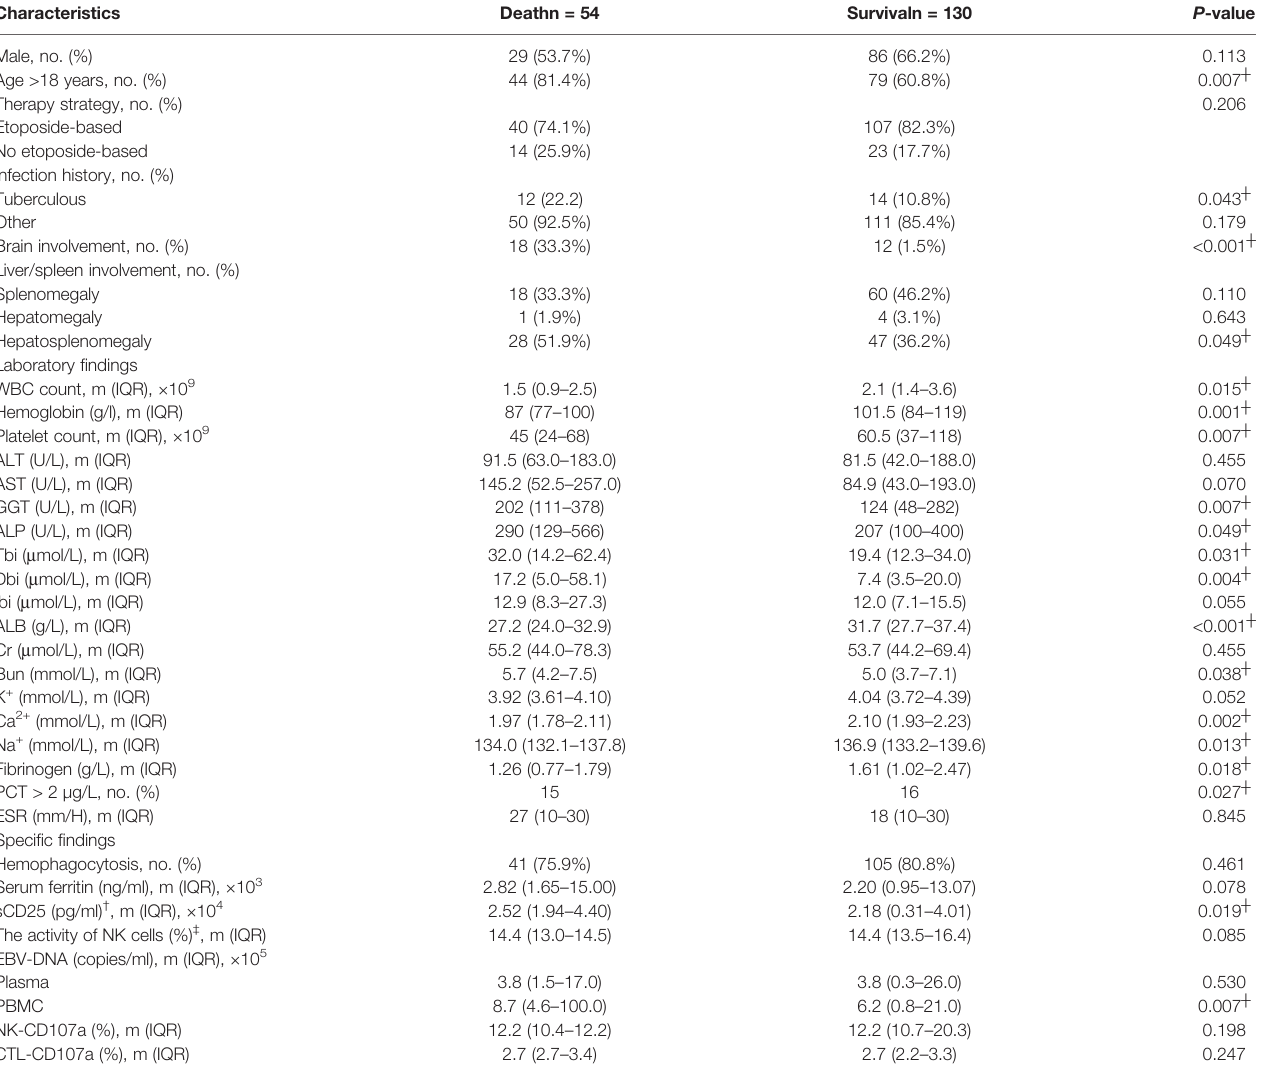
TABLE 1 | Demographic and clinical information of patients with EBV-HLH in the primary cohort.